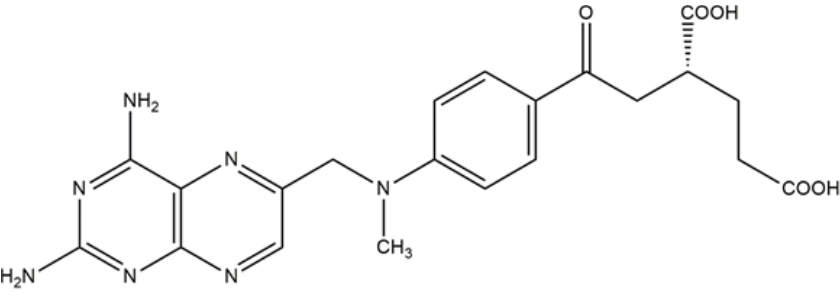
Figure 1. Chemical structure of methotrexate.